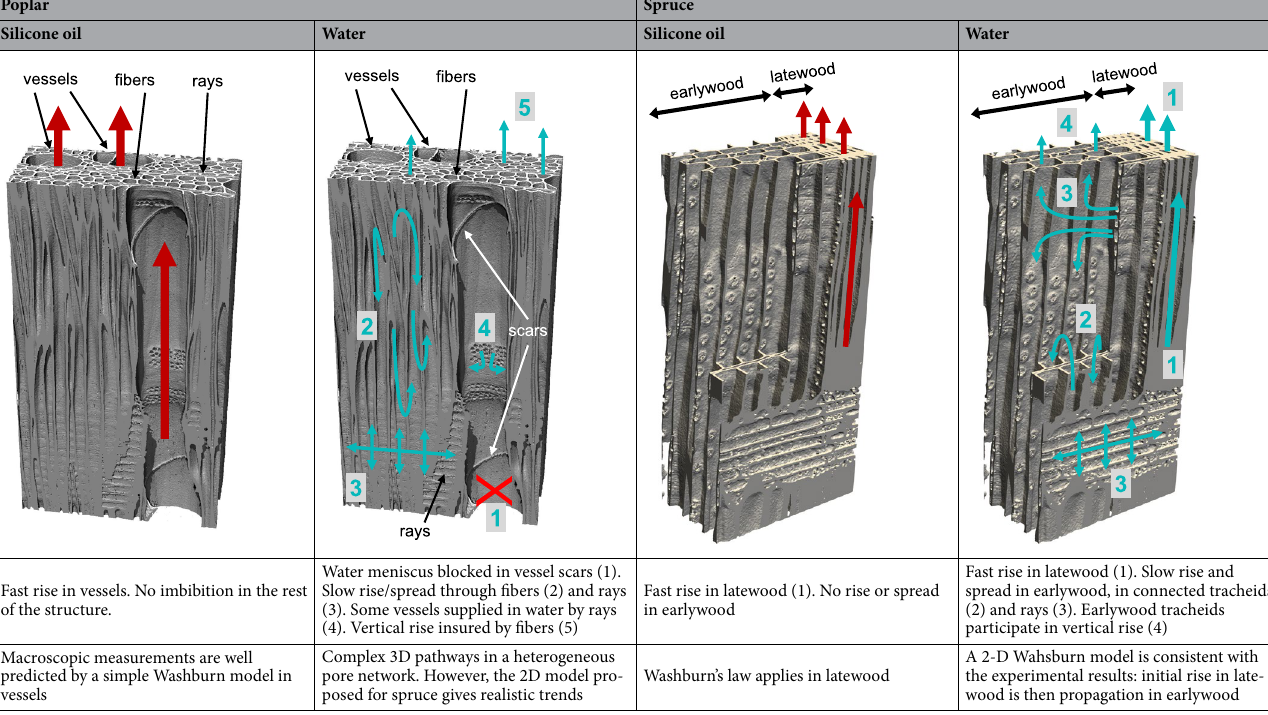
Table 4. Summary of the main results of this work (graphical illustrations by P.